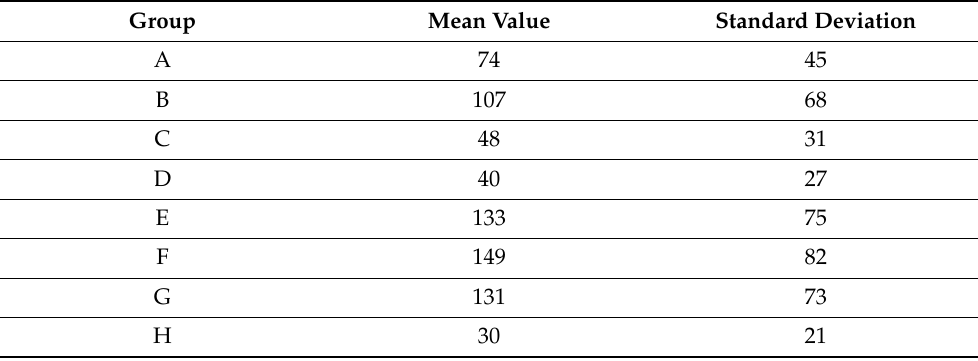
Table 1. Parameters of the Normal distributions for the arrival time of the parts.